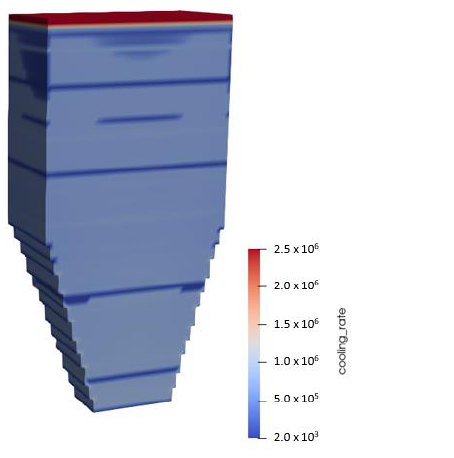
Figure 12. Solidification cooling rates distribution along the part.